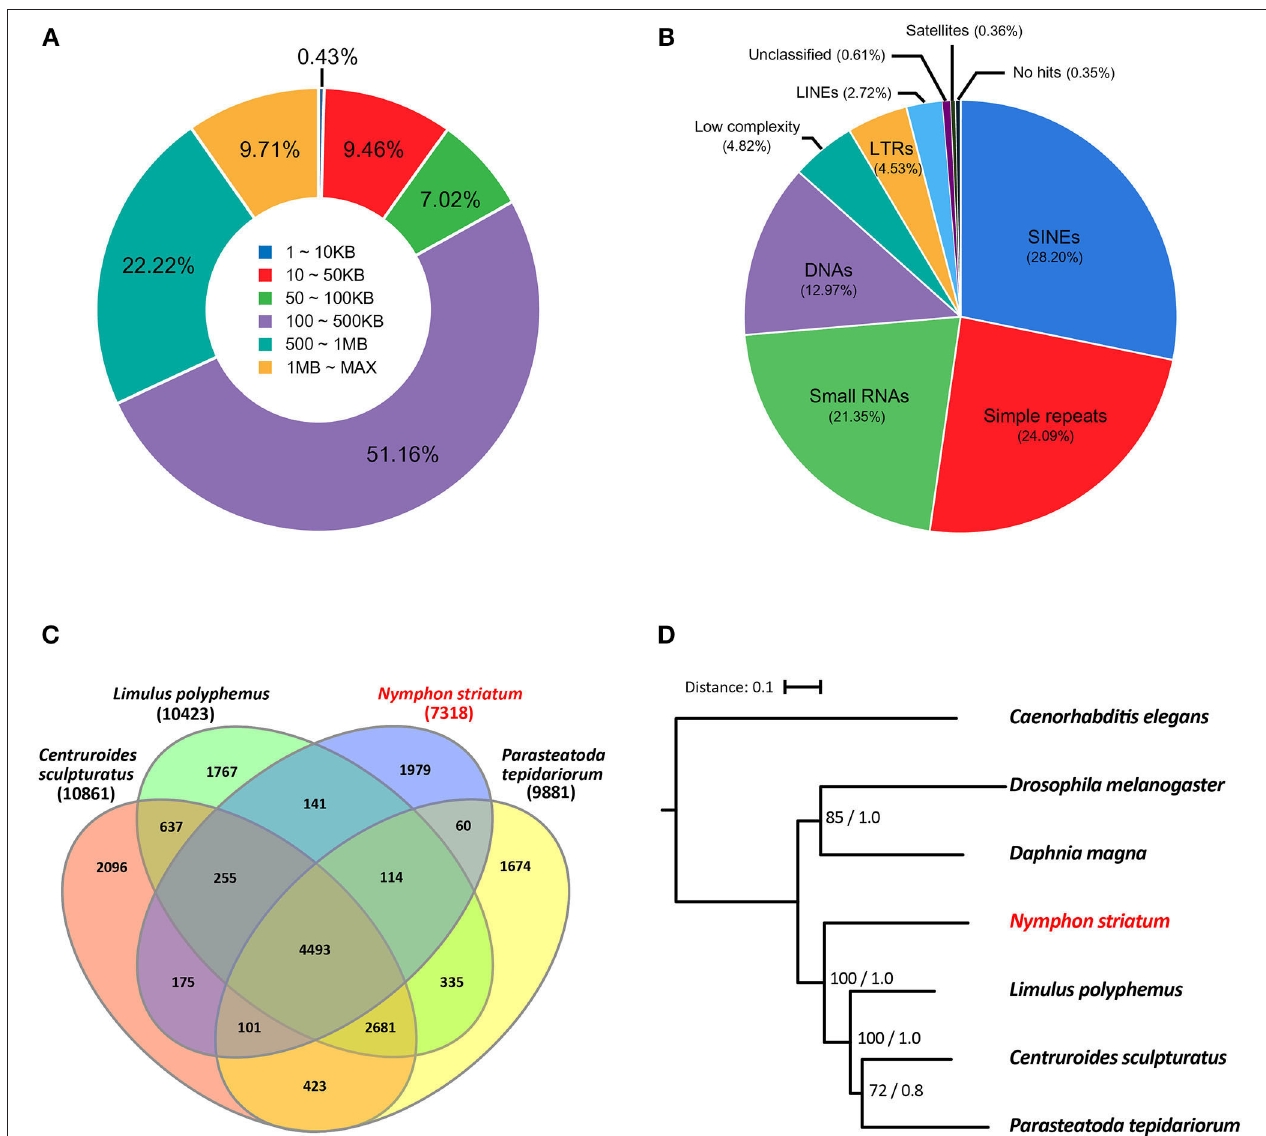
FIGURE 1 | Characteristics of the Nymphon striatum genome assembly. (A) The length distributions of the gap–closed scaffolds; (B) ab initio predicted repetitive elements and their subclass distributions; (C) a Venn diagram of the orthologous clusters among five chelicerate species; (D) the phylogenetic relationship of N. striatum with other six ecdysozoan species; Caenorhabditis elegans was selected as an outgroup taxon for the analysis. For each node, its bootstrap support value and the posterior probability are indicated at the base of the